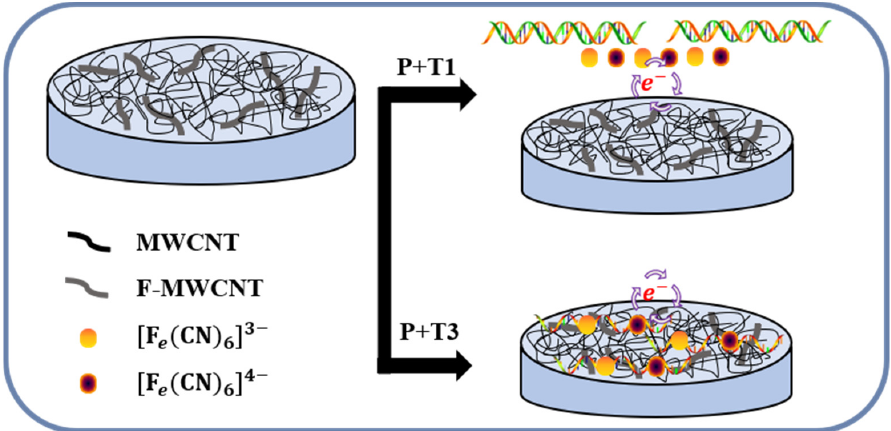
Figure 6. Schematic diagram of DNA detection mechanism.